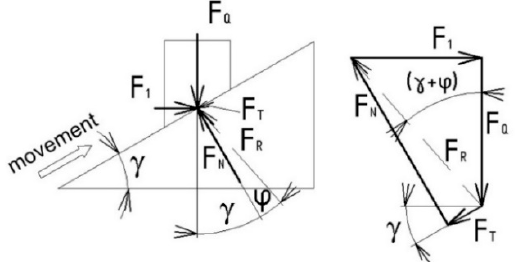
Figure 2. Ratio of the forces for motion with friction (tightening).